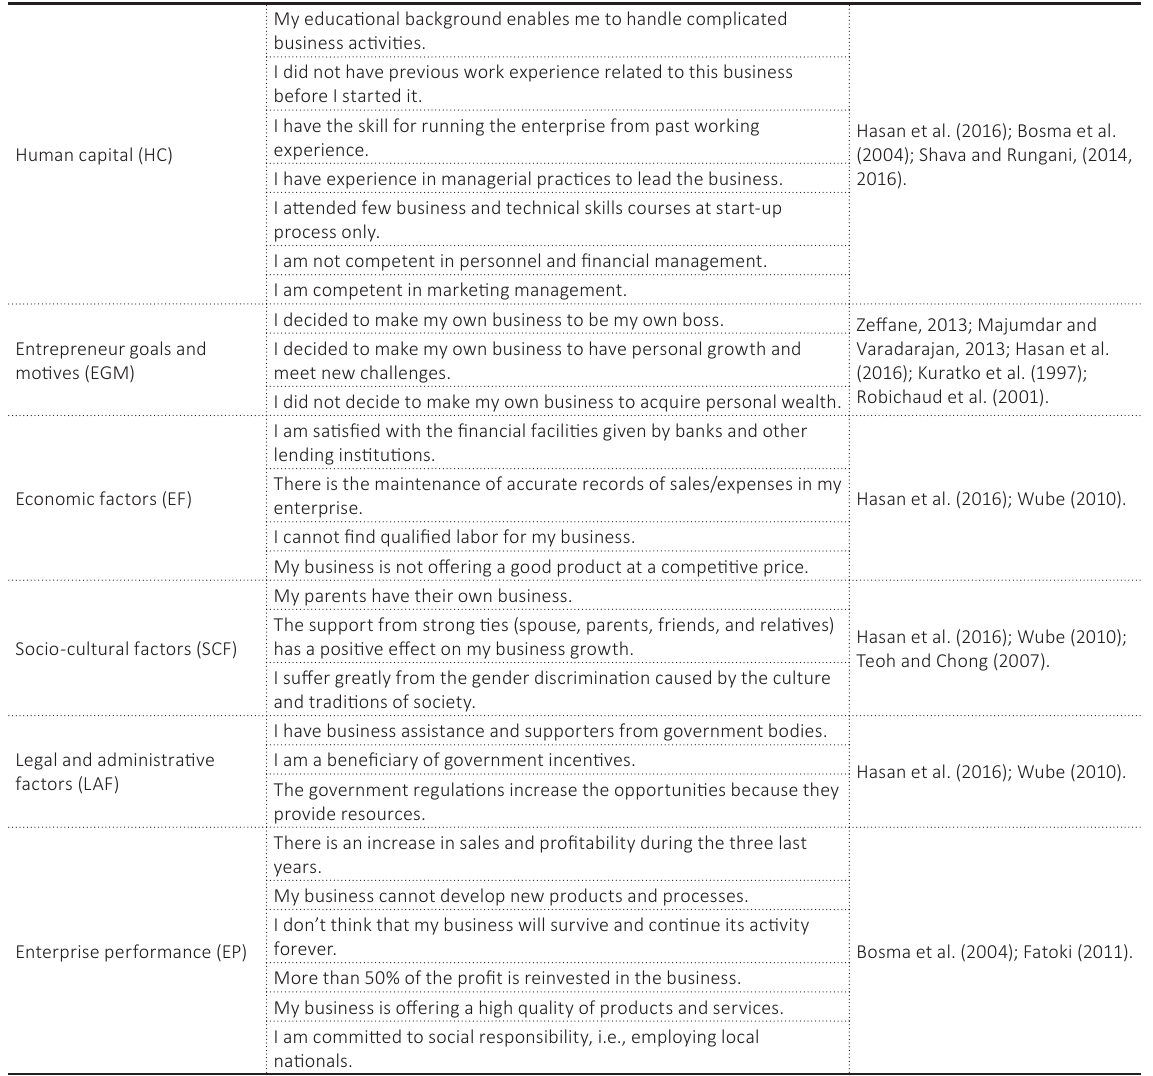
Table 1 (cont.). Scales